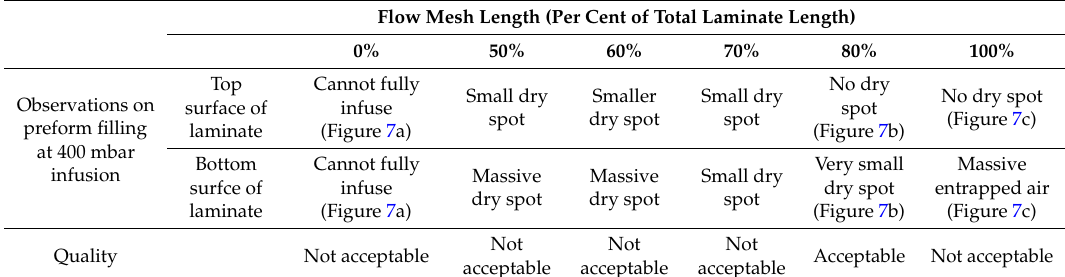
Table 4. Effect of flow mesh length on preform infusion at single stage vacuum.